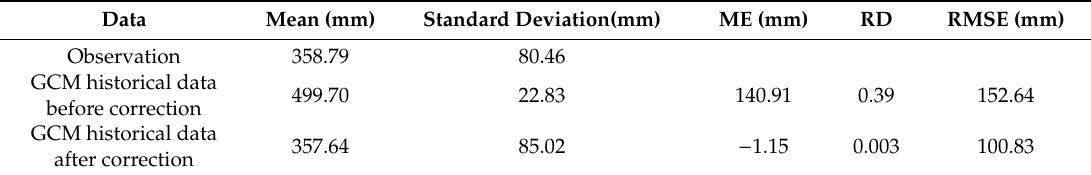
Comparison of annual precipitation before and after deviation correction in the Huangfuchuan